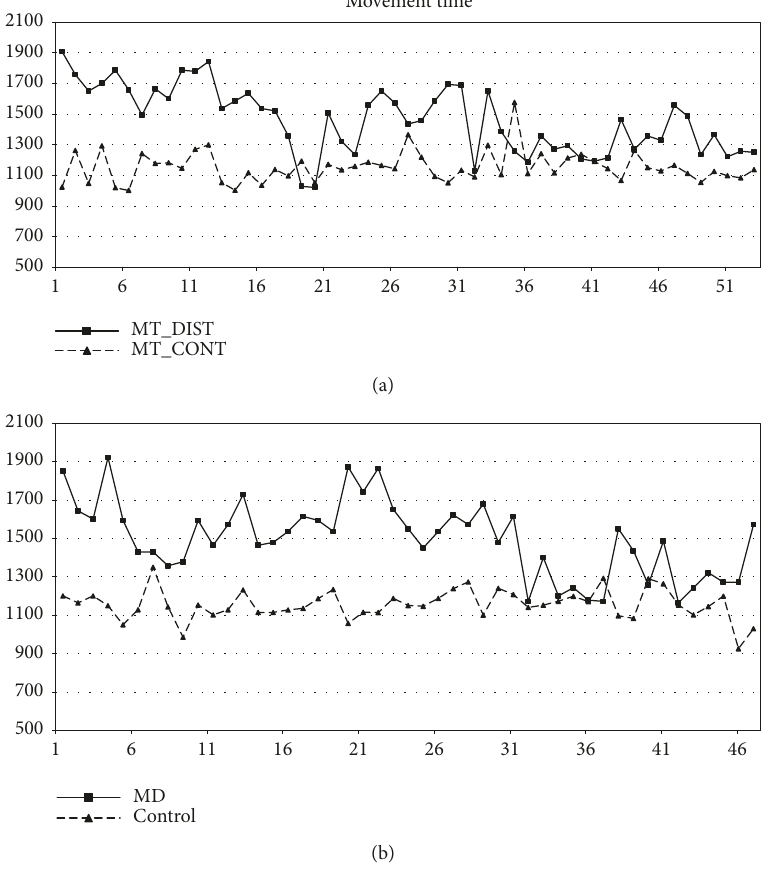
Figure 6: MD and control participant trends on the movement time (task 2). Table 1: Resting motor threshold variations throughout the fi ve- day protocol, before (rMT pre) and after (rMT post) the rTMS 1Hz stimulation at the 90 percent of the